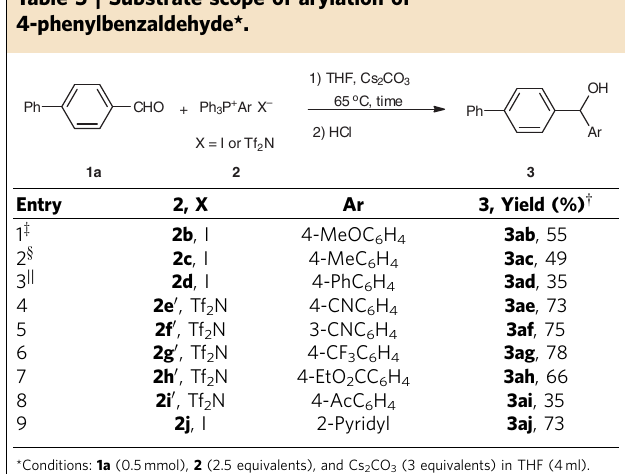
Table 4 | Substrate scope of phenylation of